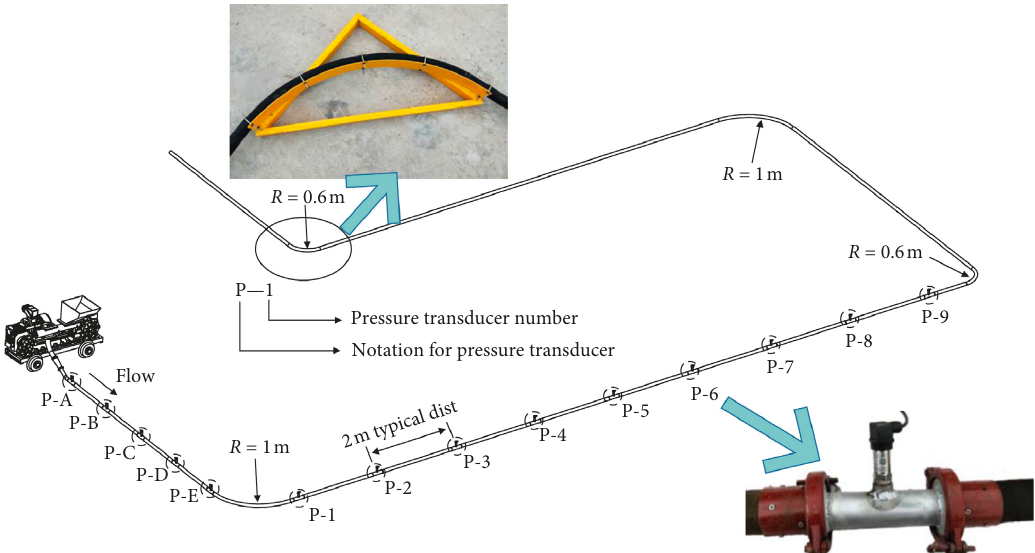
Figure 2: Structure of concrete